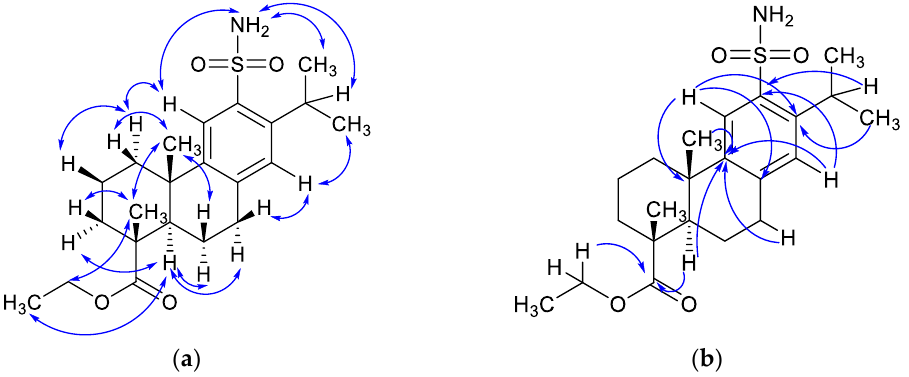
Figure 1. ( a ) Selected nuclear Overhauser effect (NOE) correlations for ethyl 12-sulfamoyl-abieta-8,11,13-trien-18-oate ( 3 ); ( b ) Selected heteronuclear multiple bond correlation (HMBC) for ethyl 12-sulfamoyl-abieta-8,11,13-trien-18-oate ( 3 ).